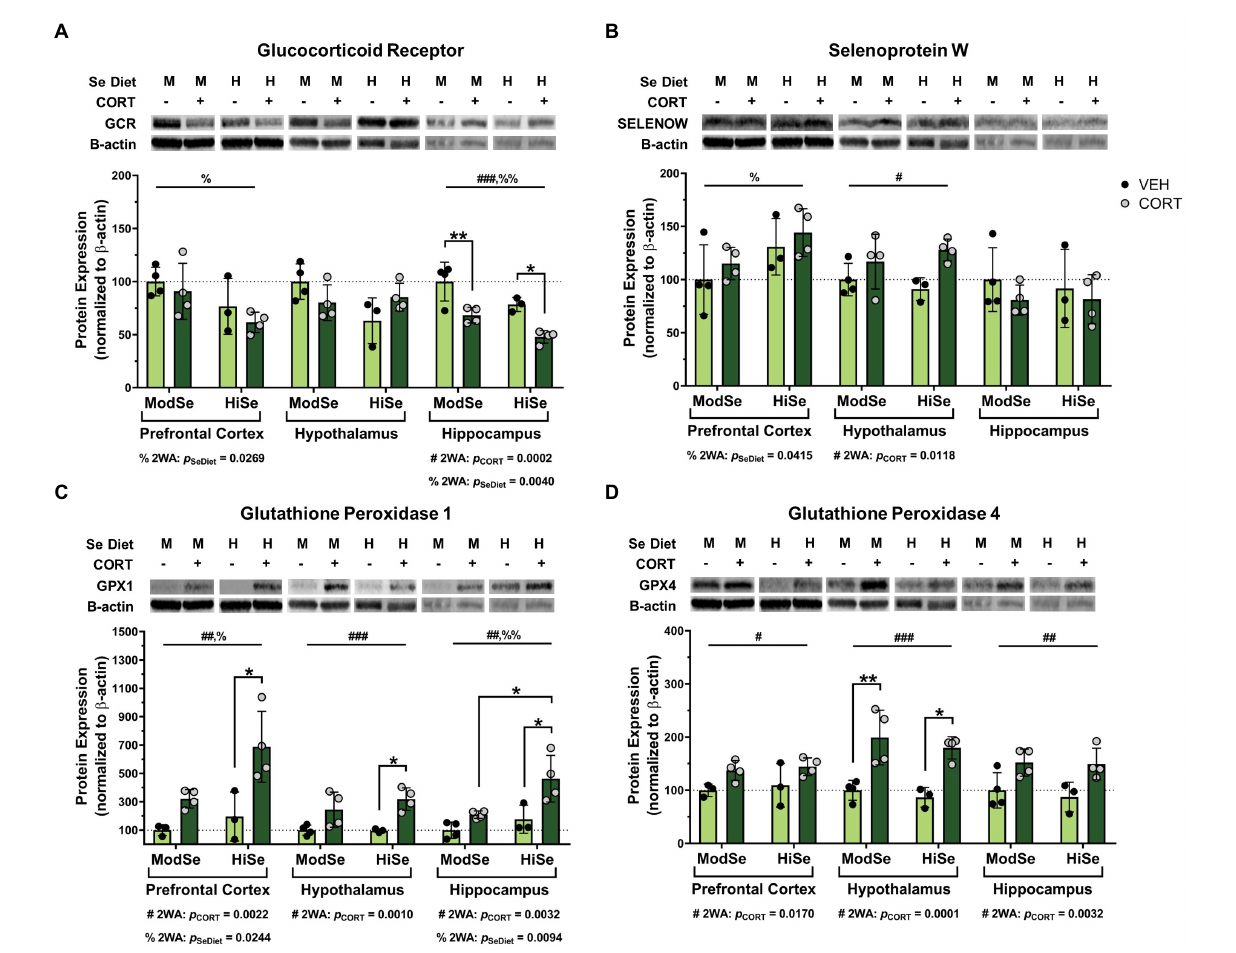
FIGURE 3 Western blot analysis in the prefrontal cortex (PFC), hypothalamus (HYP), and hippocampus (HPC) of female mice on a moderate (ModSe) or high selenium (HiSe) diet being treated with either CORT or vehicle control (VEH). (A) Percentage change in glucocorticoid receptor (GCR) protein levels. CORT significantly reduced GCR in the HPC [p CORT = 0.0002, F (1,11) = 28.70]. As with male offspring, maternal consumption of HiSe decreased GCR levels in the HPC [p SeDiet = 0.0040, F (1,11) = 13.14], however this effect was also observed in the PFC[p SeDiet = 0.0269, F (1,11) = 6.514]. (B) Percentage change in SELENOW protein levels. CORT significantly increased SELENOW levels in the HYP: p CORT = 0.0118, F (1,11) = 9.075. HiSe also increased SELENOW in the PFC: p SeDiet = 0.0415, F (1,11) = 5.322. (C) Percentage change in GPX1 protein levels. CORT increased GPX1 levels in all three brain regions: PFC [p CORT = 0.0022, F (1,10) = 16.68], HYP [p CORT = 0.0010, F (1,11) = 19.78], and HPC [p CORT = 0.0032, F (1,11) = 14.02]. HiSe increased GPX1 in both the PFC [p SeDiet = 0.0244, F (1,10) = 7.009] and the HPC [p SeDiet = 0.0094, F (1,11) = 9.852]. (D) Percentage change in GPX4 protein levels. CORT elevated GPX4 levels in all brain regions: